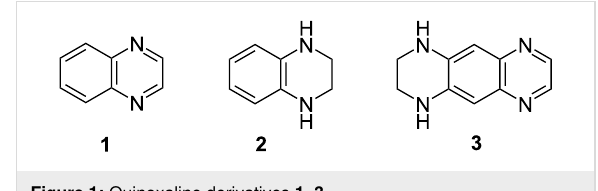
Figure 1: Quinoxaline derivatives 1 – 3 .